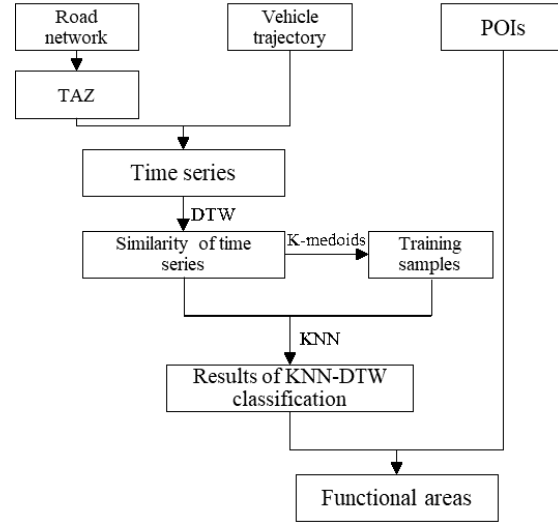
Figure 3. Flow chart of the research. The figure shows the process of urban functional areas identification based on taxi trajectory data and POI data, including the generation of time series, K-medoids clustering, selection of training samples and k-nearest neighbour classification.